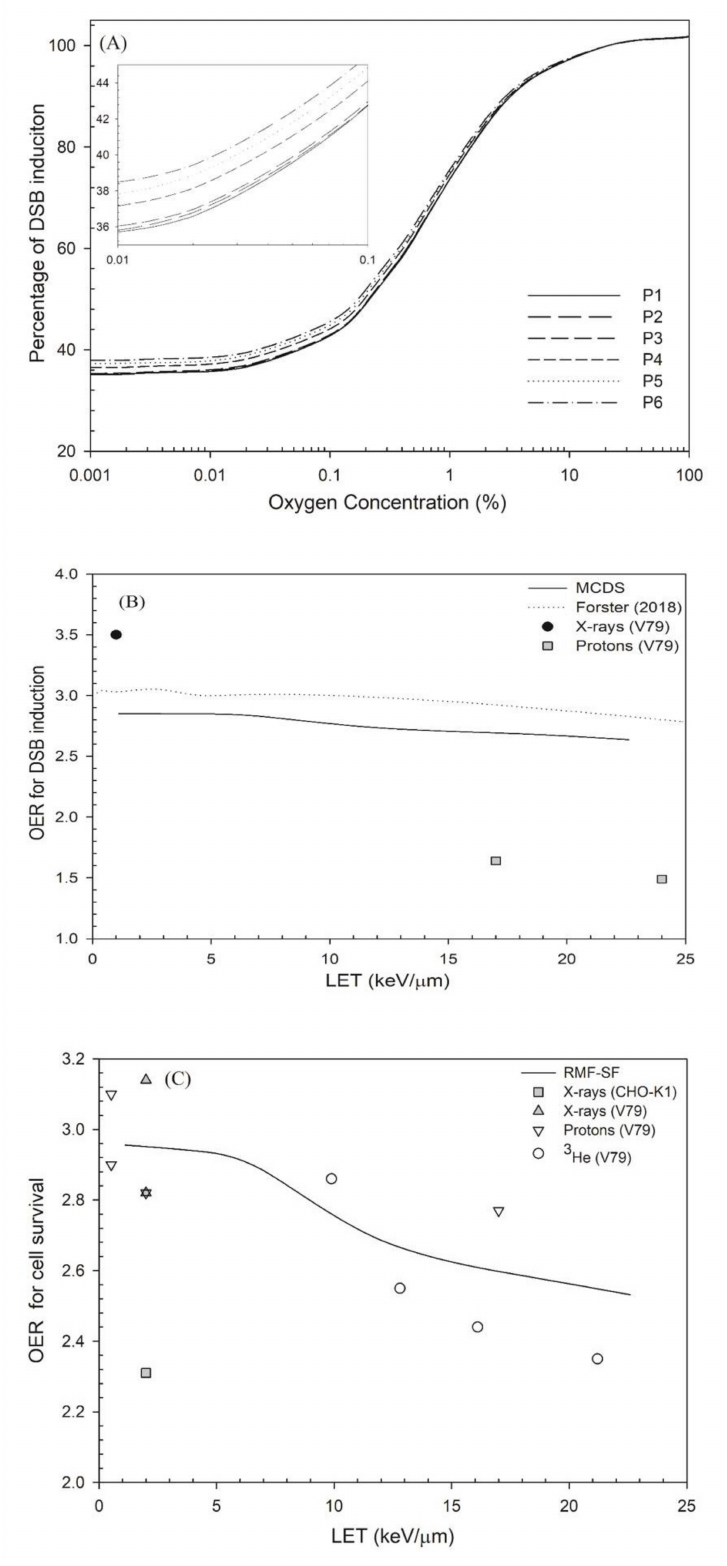
Figure 2. ( a ) Percentage of DSB induction versus oxygen concentration, ( b ) OER for DSB induction using the simulation results of Forster et al. (2018) [60] and this study (MCDS). The experimental data were taken from Prise et al. (1990) [61]. ( c ) OER for cell survival at 10% versus LET. When oxygen concentration decreases to 0.1%, the parameter j has a value of 7 to achieve the best fit to the measured OER data. These measured OER values were taken from published studies: CHO-K1 cells [62] and V79 cells irradiated by X-ray [48,61], proton ions [61] and helium ions